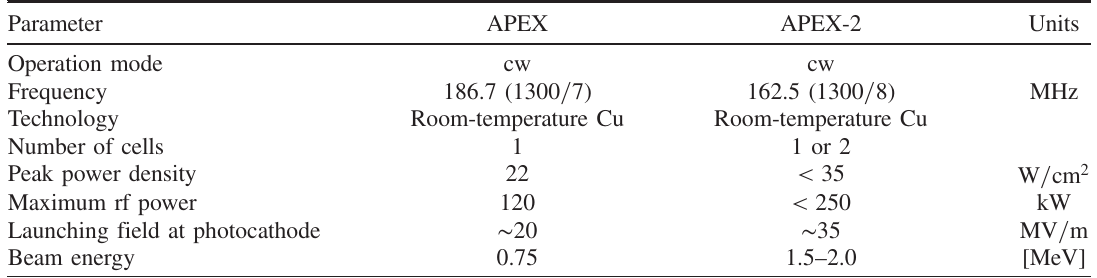
TABLE II. Present APEX VHF-gun actual parameters vs APEX-2 goal